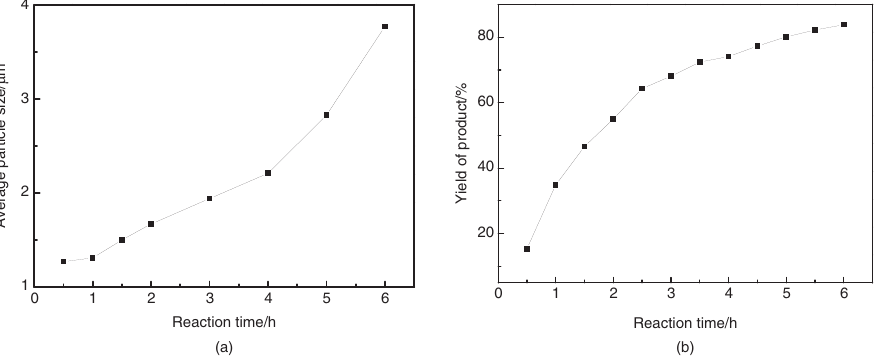
Figure 6: Effect of reaction time on average particle size (a) and yield of product (b) in the microwave homogeneous precipitation,